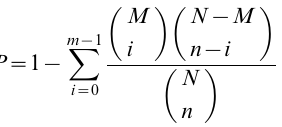
Figure S1 Saturation analysis of sequencing. Figure S2 Gene expression level in PGs during different developmental stages. ‘‘Not DEGs’’ indicates ‘‘not detected expression genes’’. X-axis and Y-axis present log10 of the transcript per million of differentially developed stages of PGs. P , = 0.001 and absolute value of log2 . =1 were used as the thresholds. Table S1 Differentially expressed genes between 2 72 h and 0 h PGs. Table S2 Differentially expressed genes between 2 72 h and